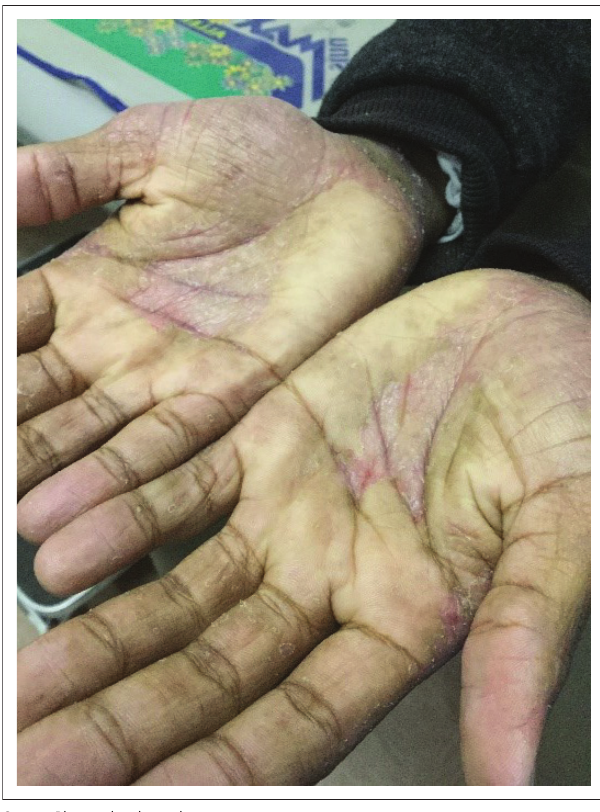
FIGURE 2: Chronic irritant contact dermatitis secondary to the usage of sanitisers, affecting both hands on the palmar surface.